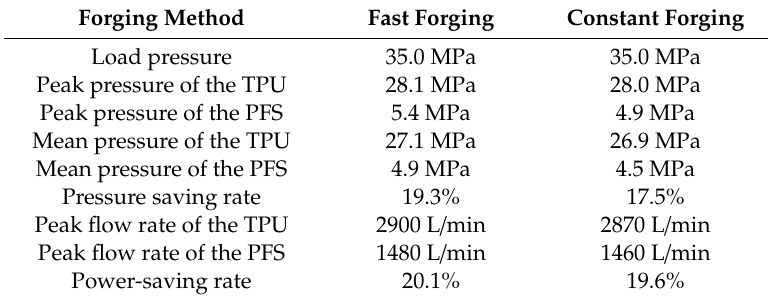
Table 2. Results of the experiments at the PS stage for di ff erent forging methods. PFS: prefill system, PS: pressing with slow falling, TPU: traditional power units.